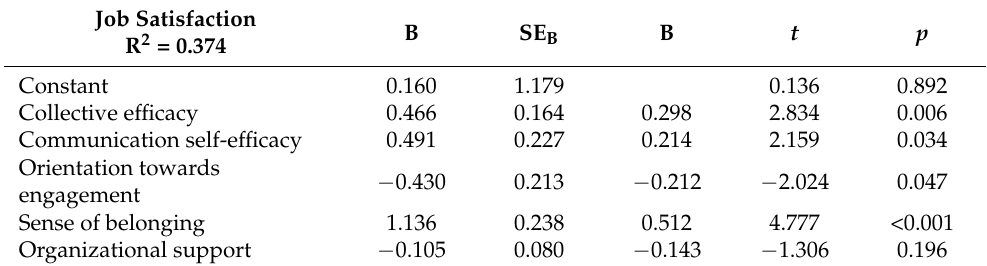
Table 4. Model 2—Multiple linear regression for physicians’ well-being ( n = 78). Mental Well-Being R 2 = 0.172